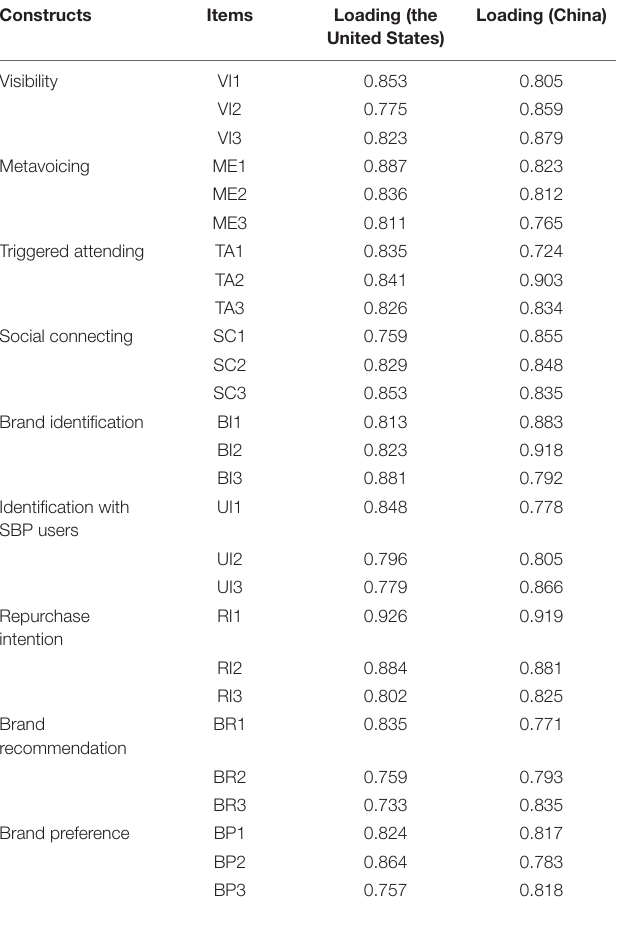
TABLE 3 | Measurement model factor